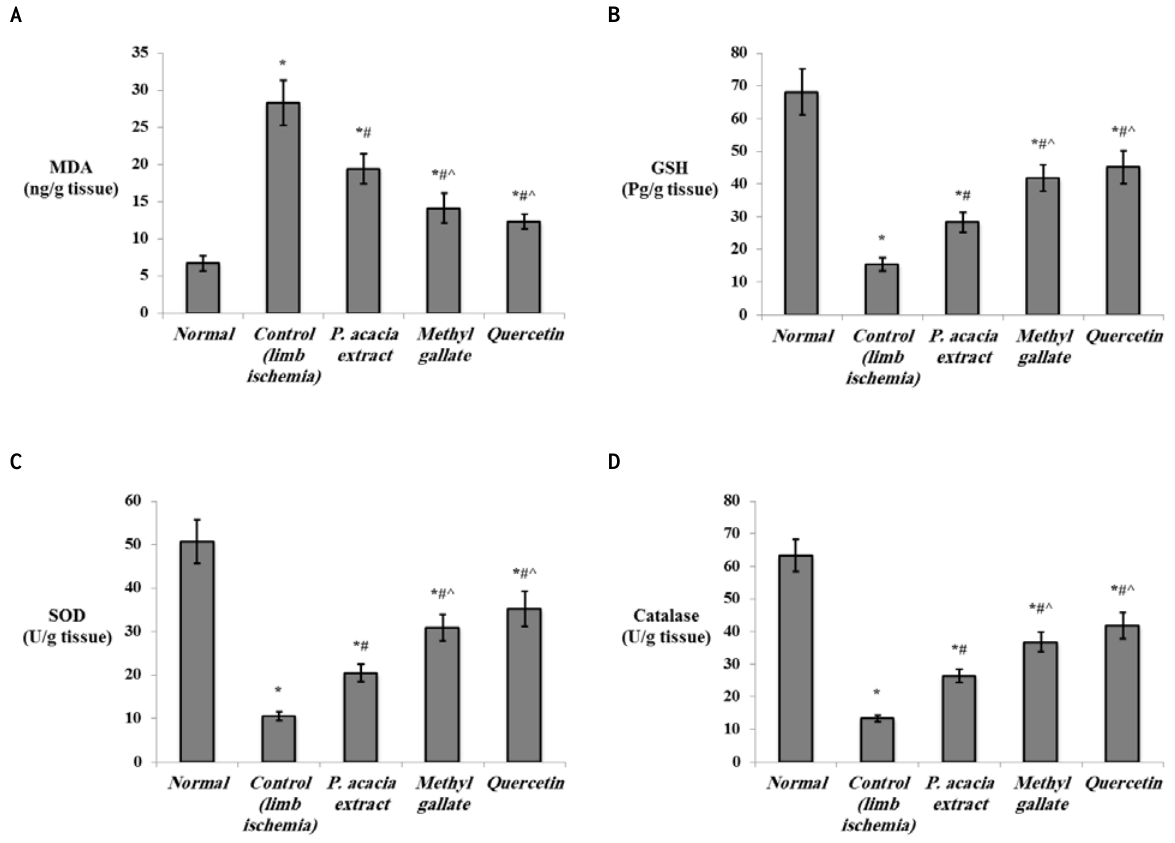
Figure 5. The effect of the P. acacia extract and its isolated compounds (methyl gallate and quercetin) on the levels of ( A ) MDA, ( B ) GSH, ( C ) SOD enzyme, and ( D ) catalase enzyme in the hind limb tissue of the experimental rats ( n = 8). MDA = malondialdehyde; GSH = reduced glutathione; SOD = superoxide dismutase. Data are expressed as the mean ± SD and were analyzed using one-way ANOVA followed by Bonferroni’s post hoc test. * Significantly different compared to the normal group, # significantly different compared to the hind limb ischemia control group, ˆ significantly different compared to the group treated with the P. acacia extract. Values were considered significantly different at p < 0.05.